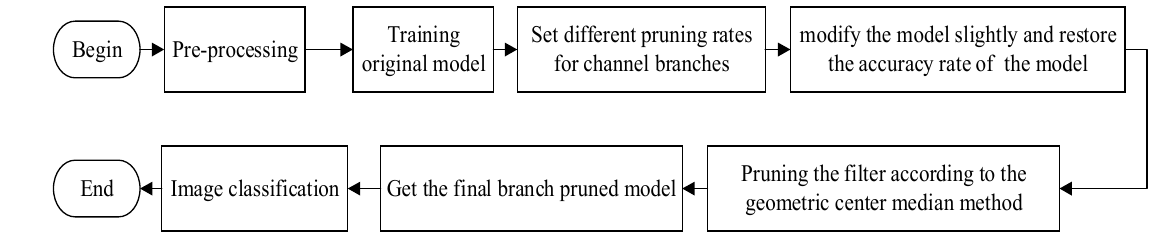
Figure 1. Flowchart of parallel pruning algorithm based on image preprocessing.